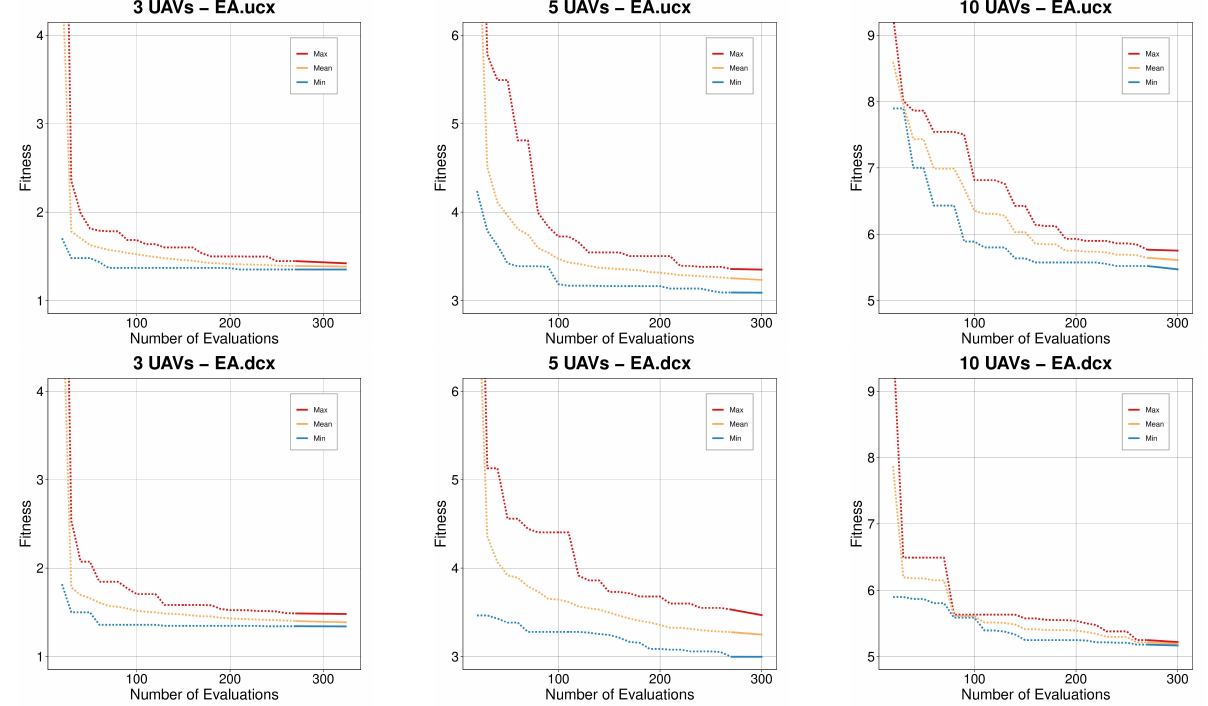
Figure 10. Convergence of the evolutionary algorithms by case study (30 runs each). The dotted lines represent the GA stages, while the continuous segments are the LS